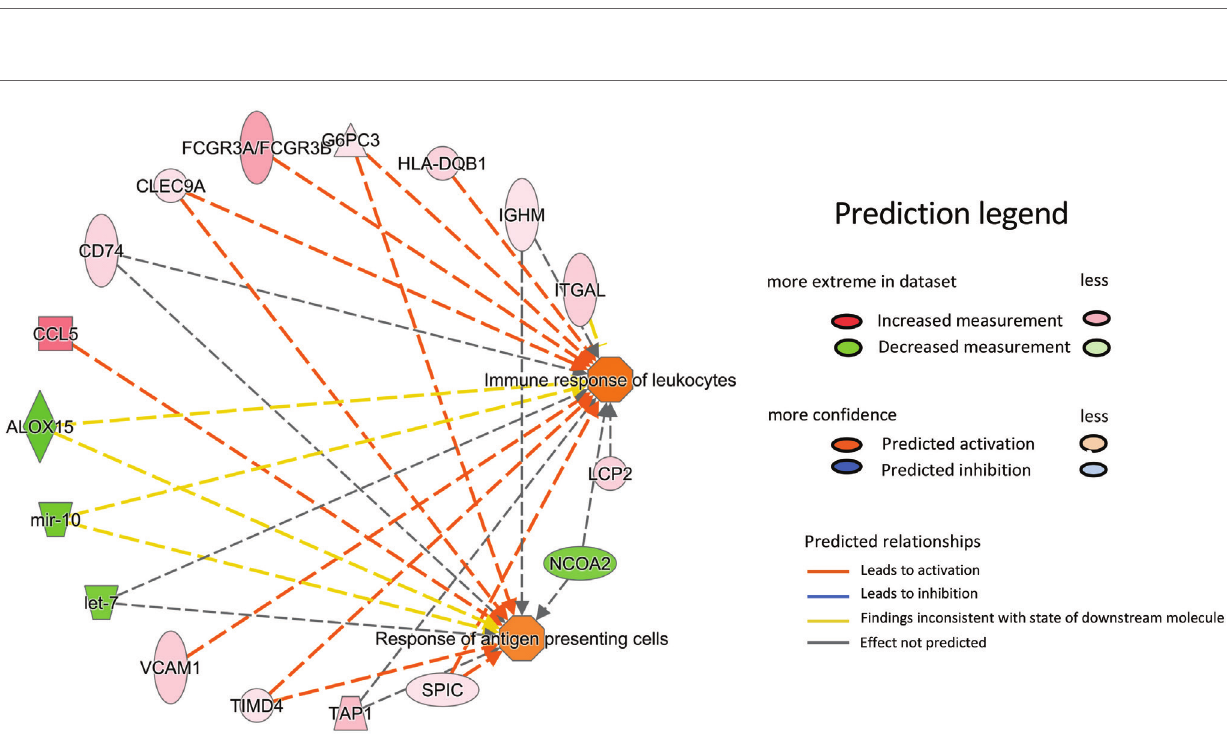
FigUre 7 | Ingenuity Pathway Analysis (IPA) of the 419 transcript cluster IDs (TCIDs) significantly altered in Tgfbr2 Δ DC epididymis. The identified pathways with overrepresented TCIDs are depicted on the X -axis. Left Y -axis denotes the percentage of genes among the 419 TCIDs in the total number of genes in any given category (total number of genes in each pathway is directly above each stacked bar). Right Y -axis (yellow line) depicts negative logarithm of the p -value for each pathway. The number of upregulated genes in Cre + mice is depicted in red, while downregulated genes are shown in green.